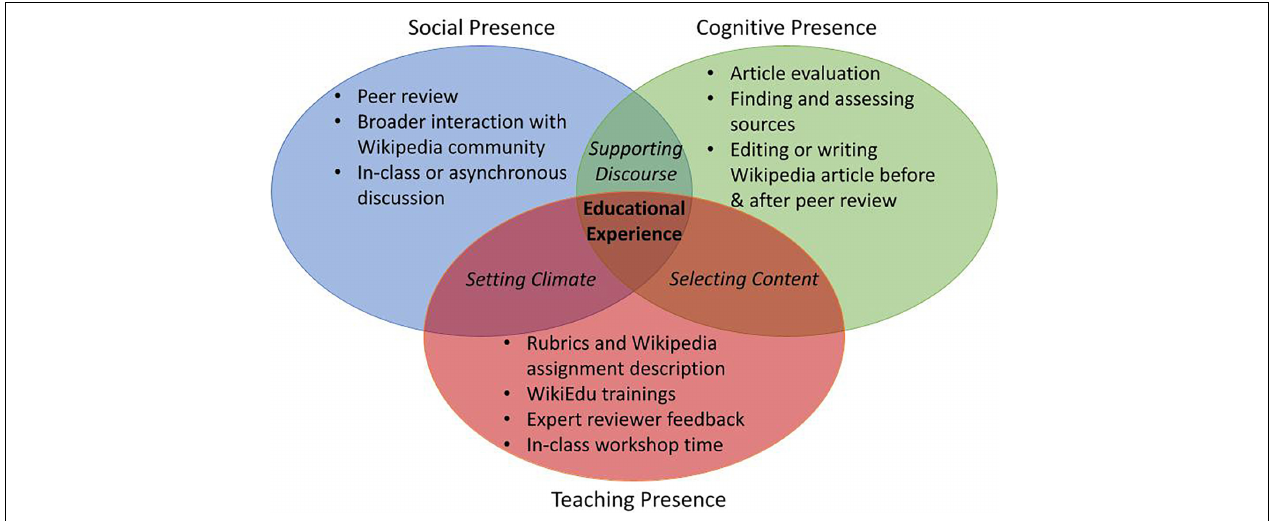
FIGURE 1 | Conceptual model of the Community of Inquiry framework (Garrison and Arbaugh, 2007), adapted to include parts of a Wikipedia assignment that apply to the various elements of the framework. Areas of overlap indicate interdependent goals that combine to create a meaningful educational